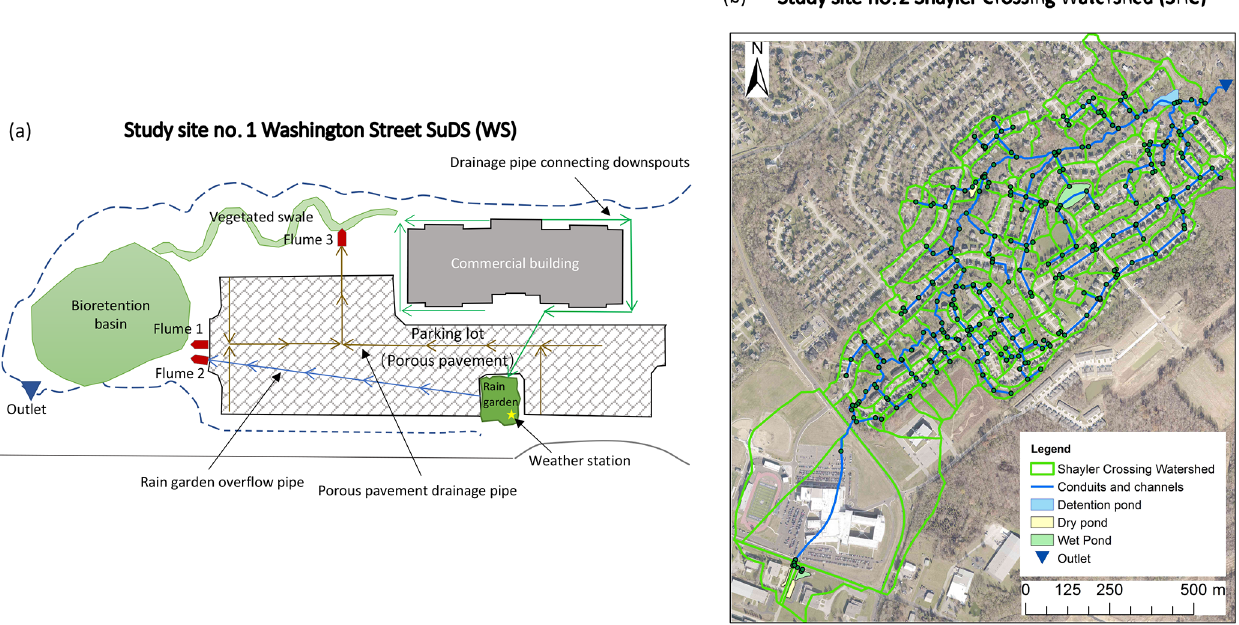
Figure 4. (a) Layout of the SuDS and monitoring network on the Washington Street site (WS), Geauga County, Ohio, USA. This figure is adapted from Darner et al. (2015). (b) Map of the Shayler Crossing Watershed (SHC). The subcatchment boundaries and drainage system shown on the map are defined by Lee et al.